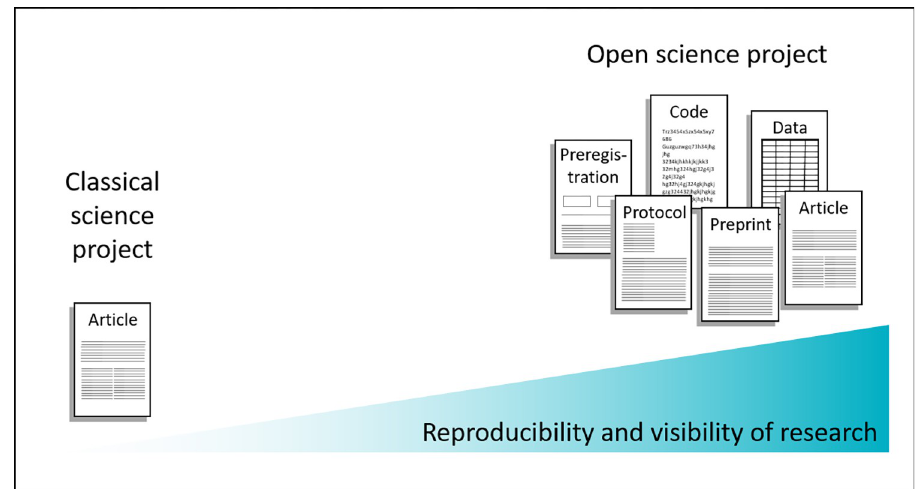
Fig 2. Published outcomes of classic versus open science projects. Application of open science practices can increase the reproducibility and visibility of a research project at the same time. By publishing different research outputs with more detailed information than can be included in a journal article, researchers enable peers to replicate their work. Reporting according to guidelines and using transparent visualization will further improve this reproducibility. The more research products that are generated, the more credit can be attributed. By communicating on social media or additionally publishing slides from delivered talks or posters, more attention can be raised. Additionally, publishing open access and making the work machine-findable makes it accessible to an even broader number of